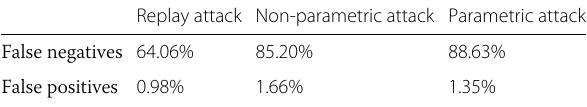
Table 4 Long run experimental